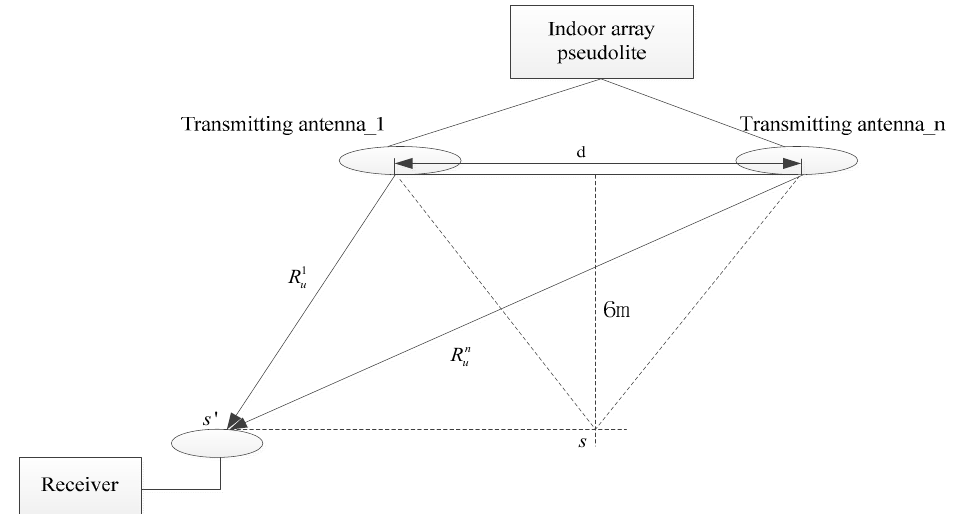
Figure 9. Geometric relationship between the transmitting antennas and receiver.